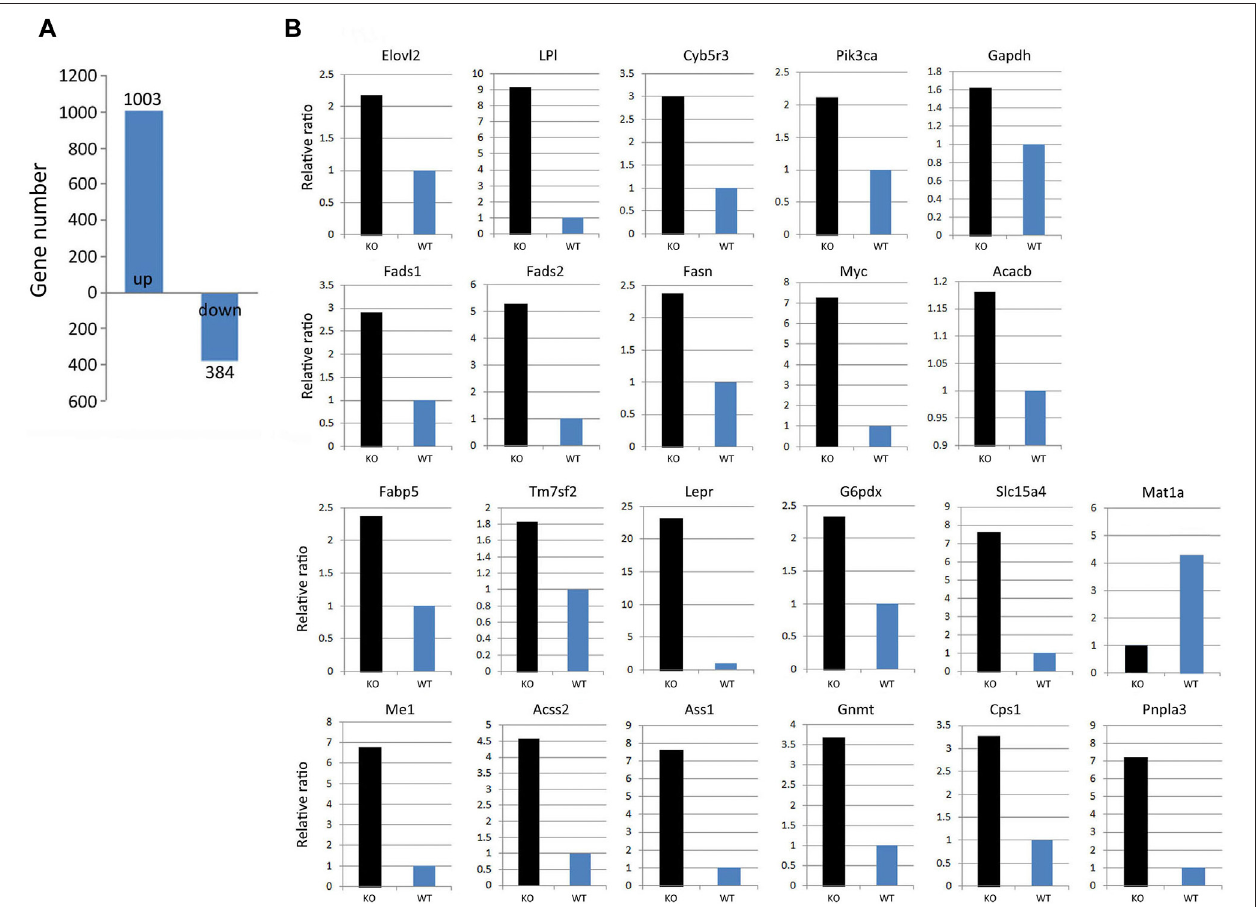
FIGURE 4 | KLF10 de fi ciency alters gene regulation in the liver. (A) Number of genes with upregulated or downregulated expression in KLF10-knockout mice compared with wild-type mice ( n (cid:1) 3). (B) Array validation was performed with qPCR for 22 selected genes. The upregulated Pnpla3 gene and downregulated Mat1a gene was used as NAFLD